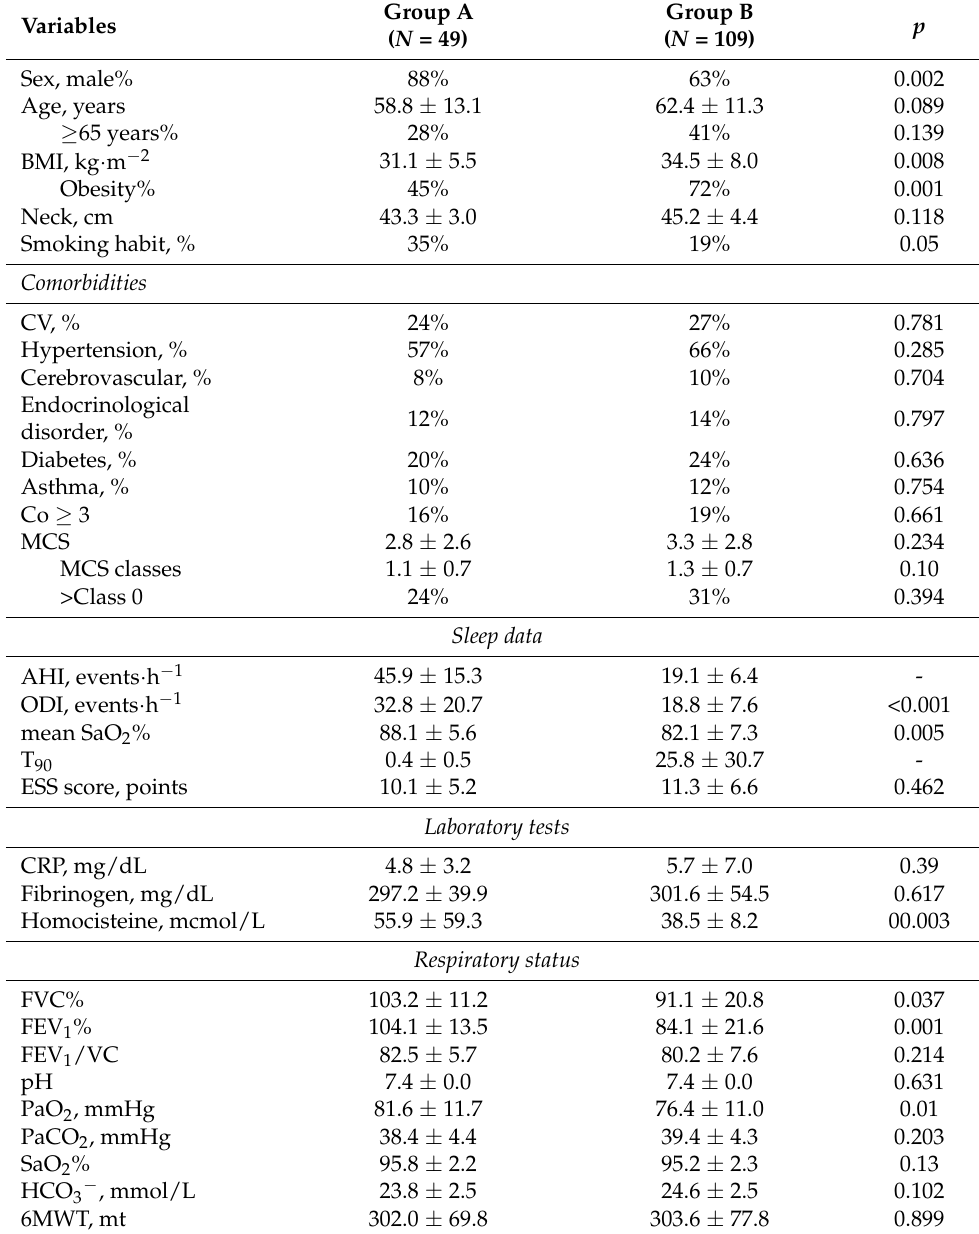
Table 3. Comparison between two phenotypes encountered: Group A (severe OSA without NH) and Group B (mild-to-moderate OSA with